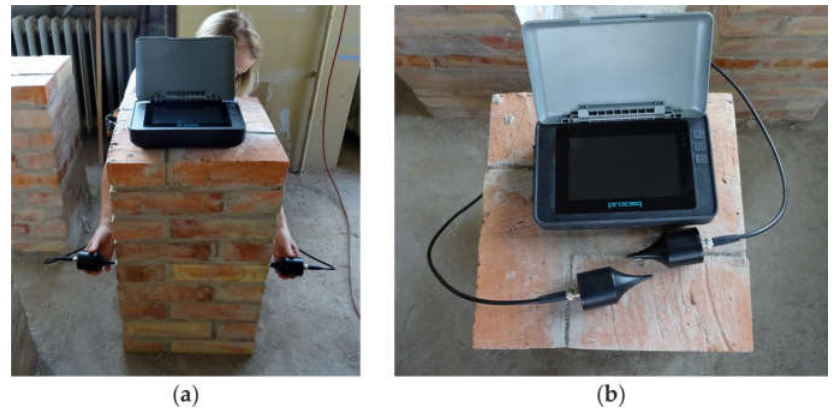
Figure 4. Experimental setup: ( a ) testing in through transmission mode; ( b ) registration unit and exponential transducers.